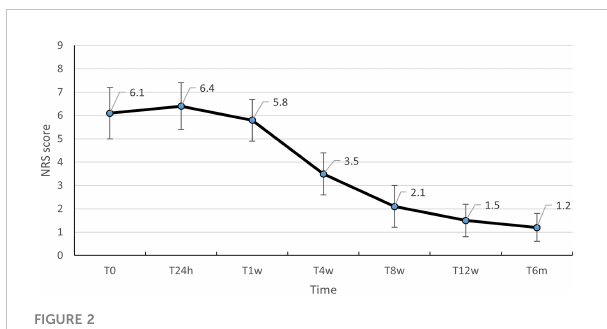
FIGURE 2 NRS score before and after the procedure. NRS, Visual Analog Scale.